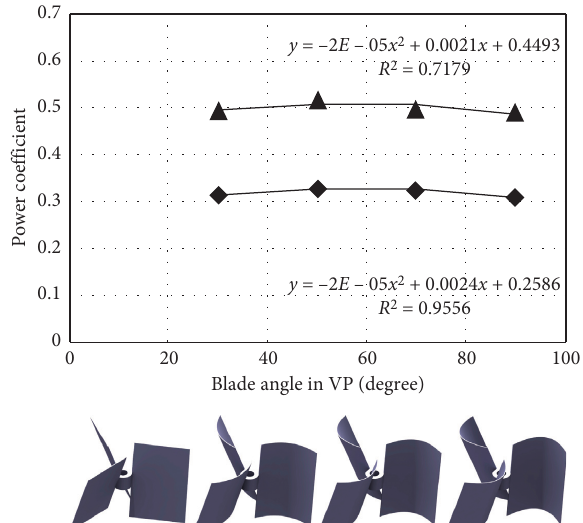
Figure 11: Set 1 data points (left to right—runners R1, R2, R3, and R4).